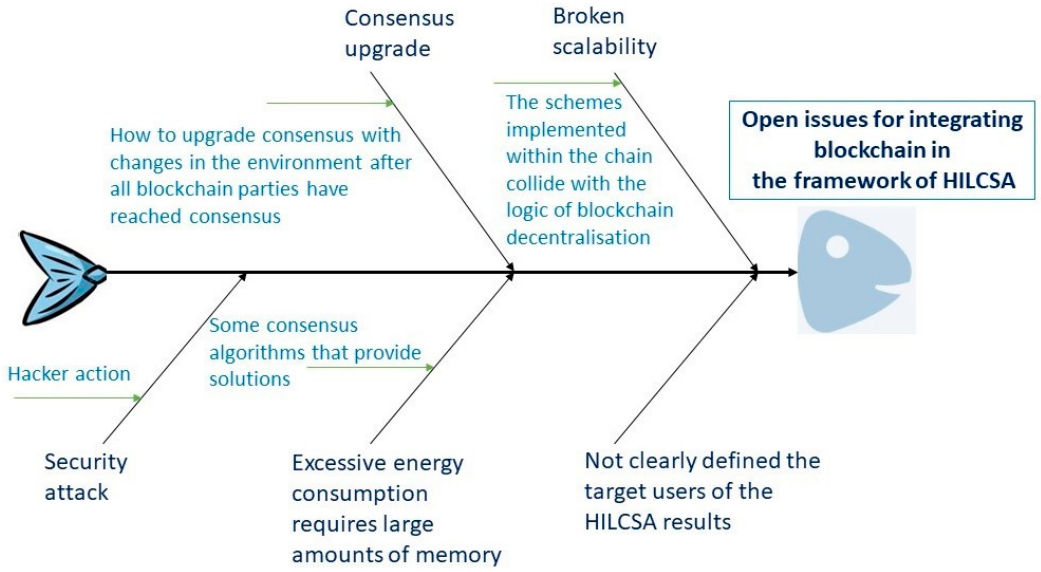
Figure 5. Ishikawa diagram—Open issues and research challenges. Source: Authors.